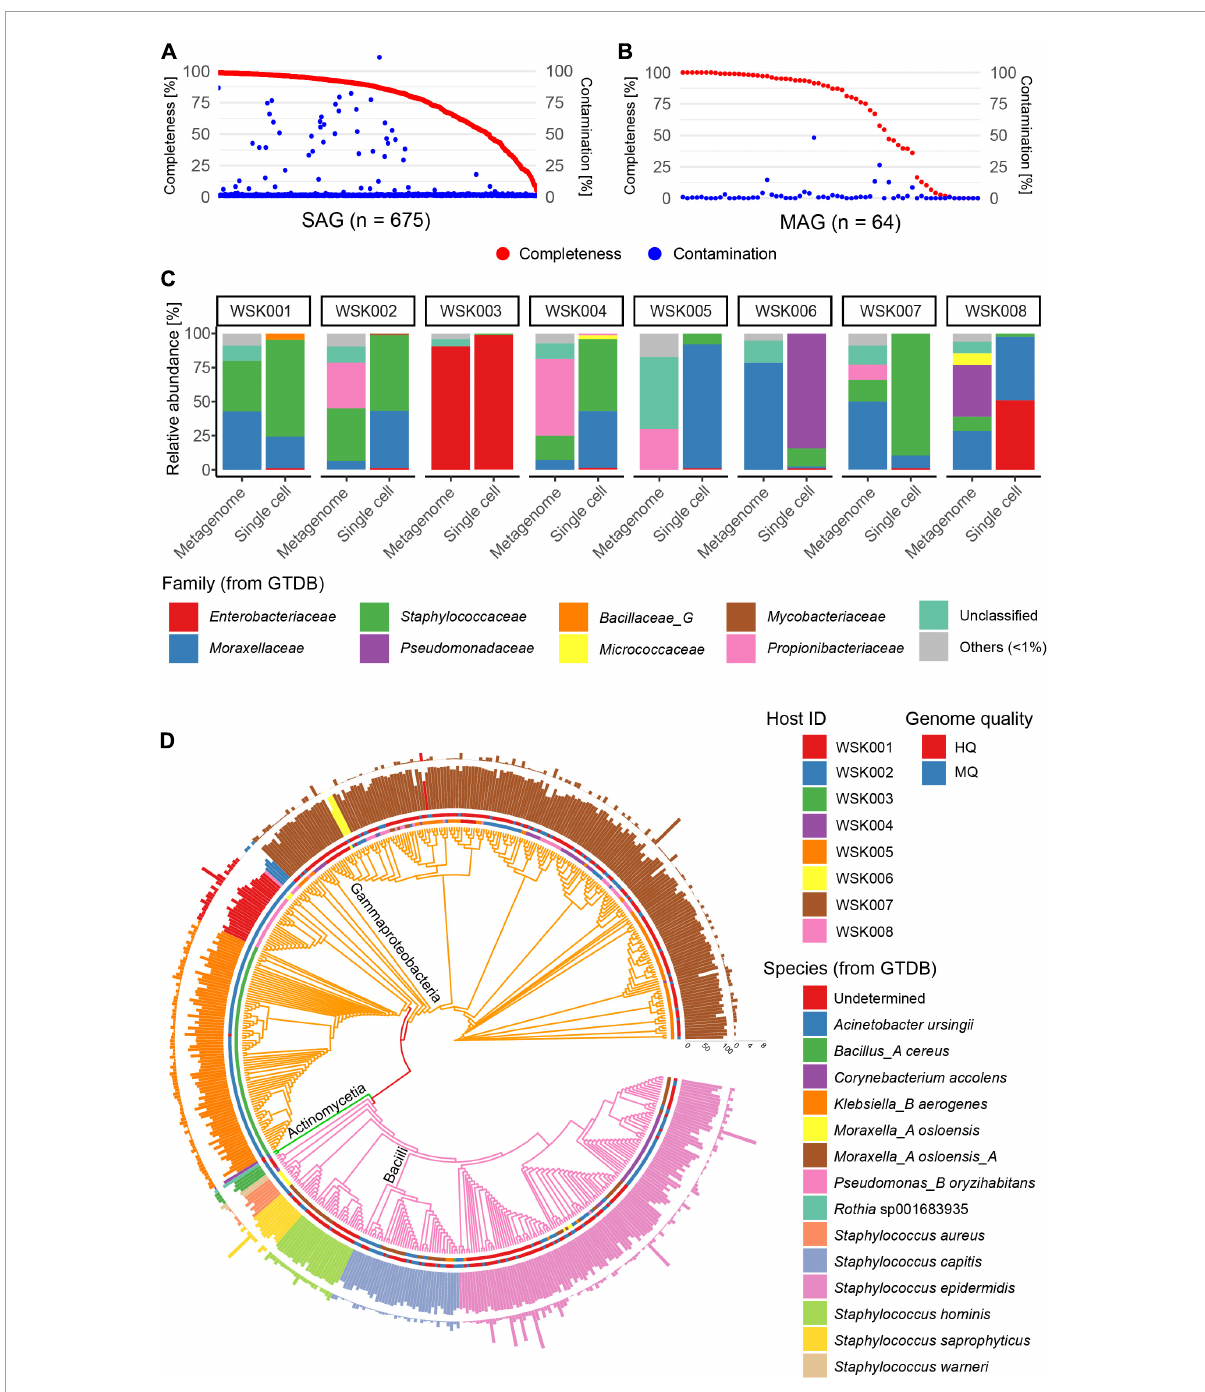
FIGURE1 Single-amplified genomes (SAGs) obtained from human skin bacteria. (A,B) Completeness and contamination statistics for (A) 675 SAGs and (B) 64 metagenome-assembled genomes (MAGs) that were obtained from 8 adult subjects, including three cohabitation groups (group1: WSK001 and WSK002, group2: WSK003 and WSK004, group3: WSK007 and WSK008). (C) Relative abundance profiles of skin bacteria in 8 individuals. Box plots indicate the phylogenetic composition calculated based on SAG numbers or metagenomic reads. (D) Taxonomic annotation of high-quality (Completeness > 90%, Contamination < 5%) and medium-quality (Completeness ≥ 50%, Contamination < 10%) SAGs. Inner circle: host; outer circle: SAG quality; inner bar: completeness; outer bar: contamination rate. Bars are colored by species. Tree edges are colored by